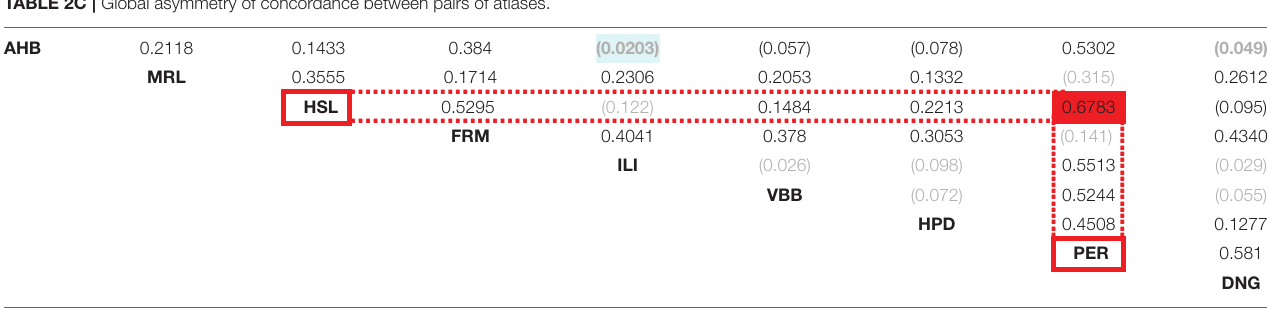
TABLE 2C | Global asymmetry of concordance between pairs of atlases.